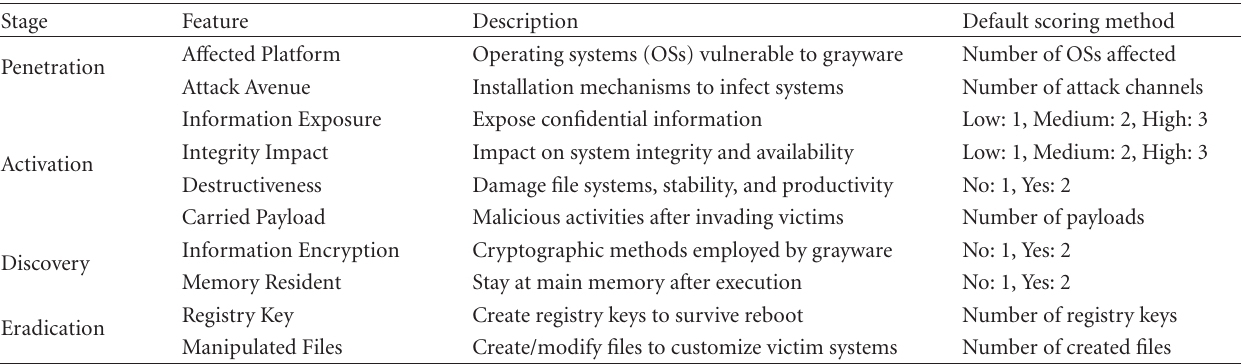
Table 8: Features used in the gray risk evaluation by the proposed